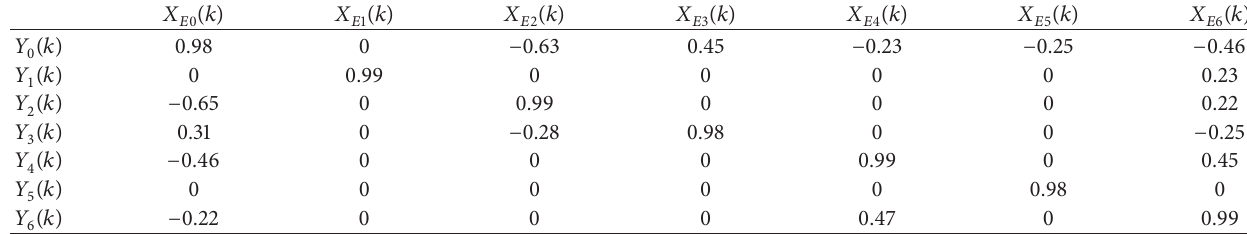
of the sensitivity of the emotional YM